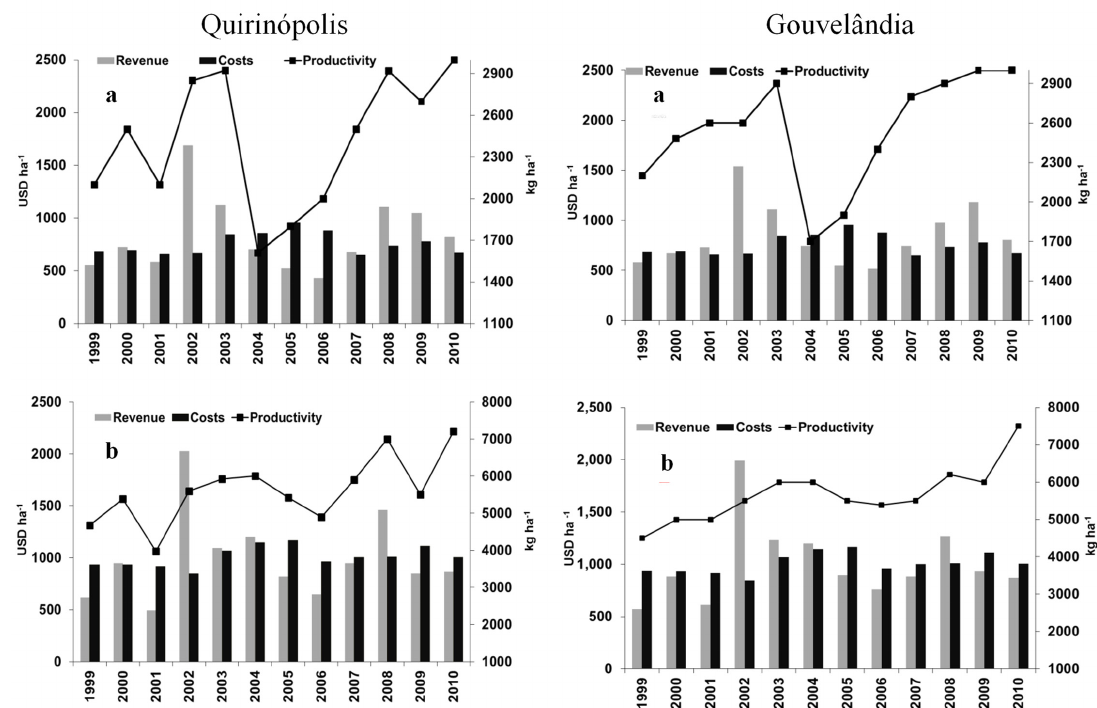
Figure 2 - Revenues, production costs and productivity of soybean (a) and maize (b) over a period of 11 years in the municipalities of Quirinópolis and Gouvelândia, Goiás, Brazil. Sources: estimated from data provided by IBGE (2012) and CONAB (2012). Revenues and production costs were inflation corrected (IPCA) in Reais (R$) and converted to US dollars (USD 1 = R$ 1.8, average exchange rate in 2010).